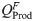
Changes in production question QProdF resulting from an update of the auditory characterization of phoneme /ɛ/ P(AΦ | [Φ = /ɛ/]).The update correspond to a combined shift of mean, μAɛ and reduction in standard-deviation σAɛ as previously defined (see Fig 11 for additional details).